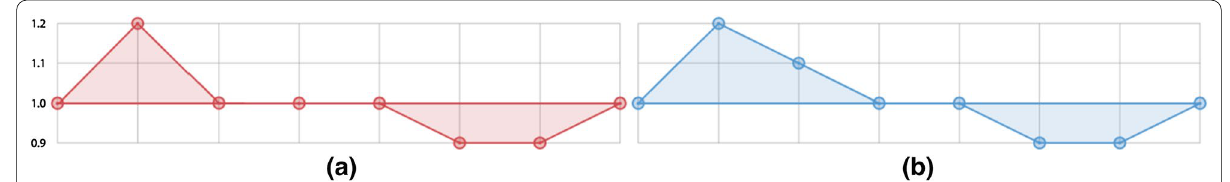
Fig. 23 The results of the two trials are identical but for the third sample, which is above baseline in